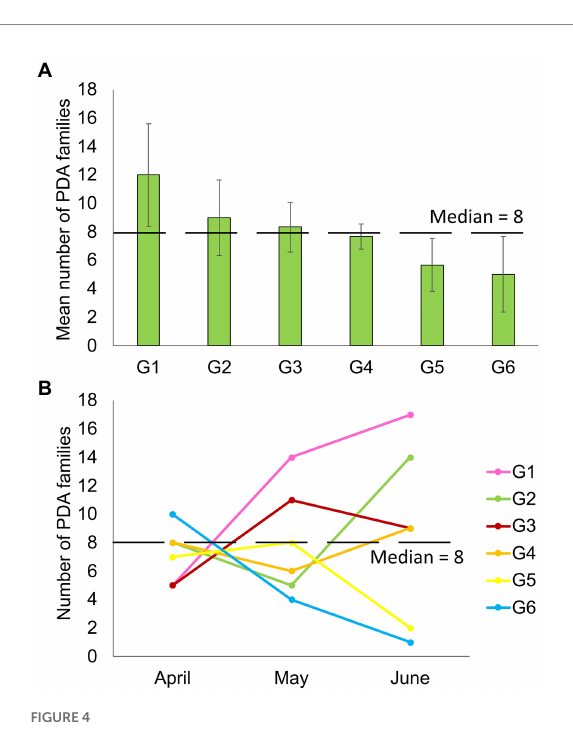
FIGURE 4 Number of plant-dwelling arthropod families ingested by six different goats (G1–G6). (A) Averaged (+SE) for each goat over three consecutive months (April–June). (B) The variation in the number of families ingested by the goats over three consecutive sampling months. The median number of families detected in all samples (8) is marked by a blacked dashed line in both